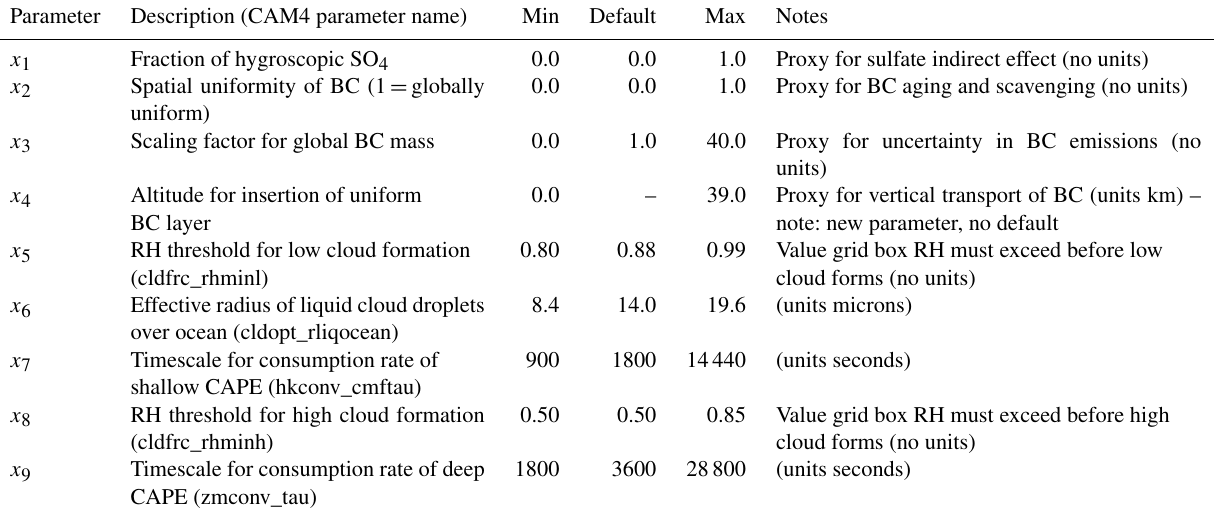
Table 1. List of parameters that are perturbed in this study, including for each parameter a description, the range of perturbed values, and the default value in CAM4 (where